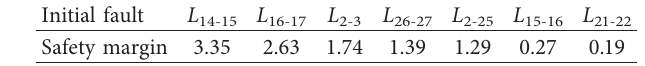
Table 3: Safety margin for each initial